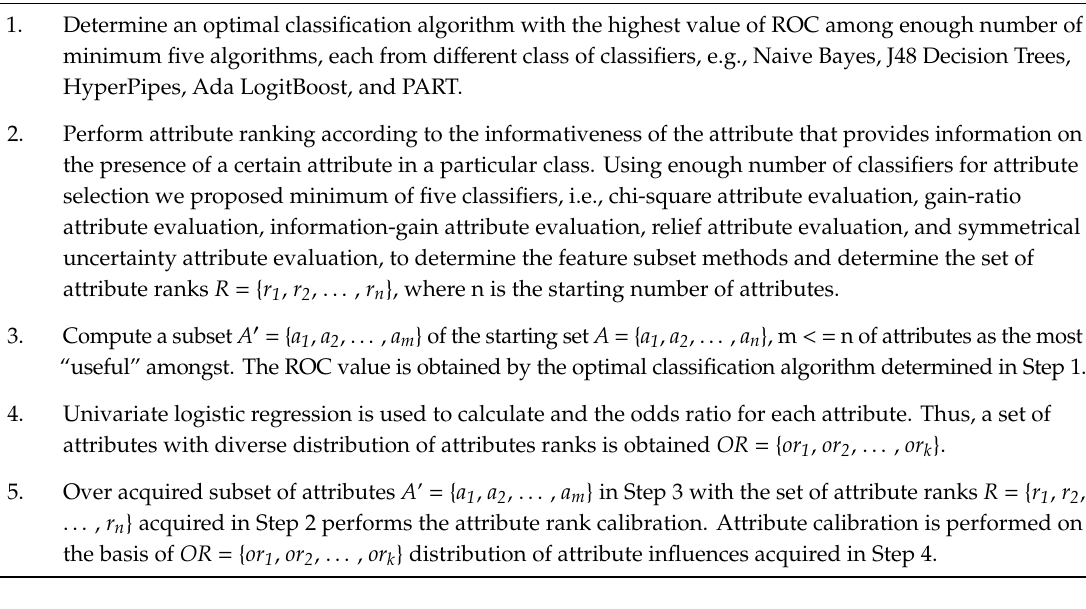
Algorithm 1: Procedure of obtaining significant predictors of bleeding in cirrhotic patients.